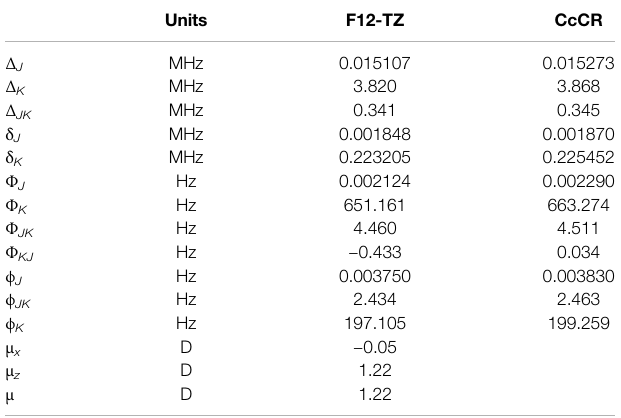
TABLE 2 | Quartic and sextic constants for AlH 2